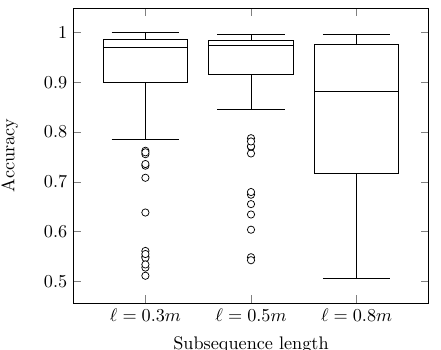
Figure 10. Accuracy of the PSF algorithm depending on the subsequence length.